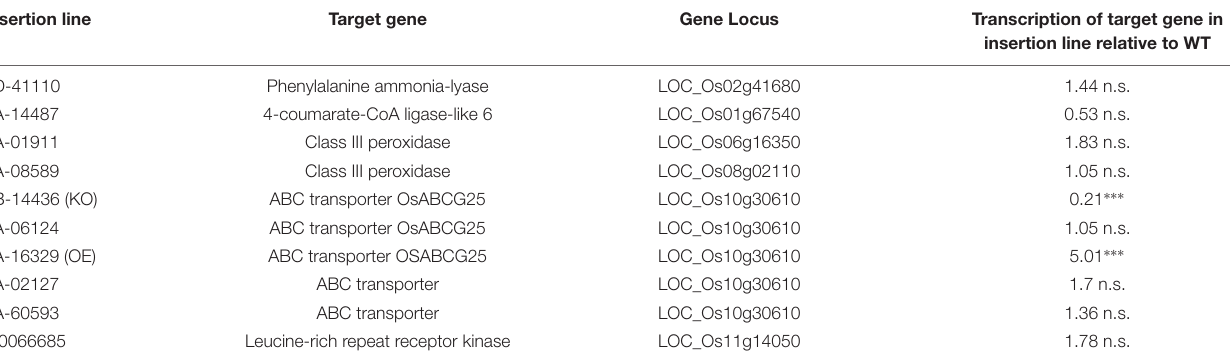
TABLE 2 | Homozygous rice insertion lines and target genes related to suberin and lignin synthesis, gene loci and changes in target gene transcription relative to wild type (WT) plants. Insertion